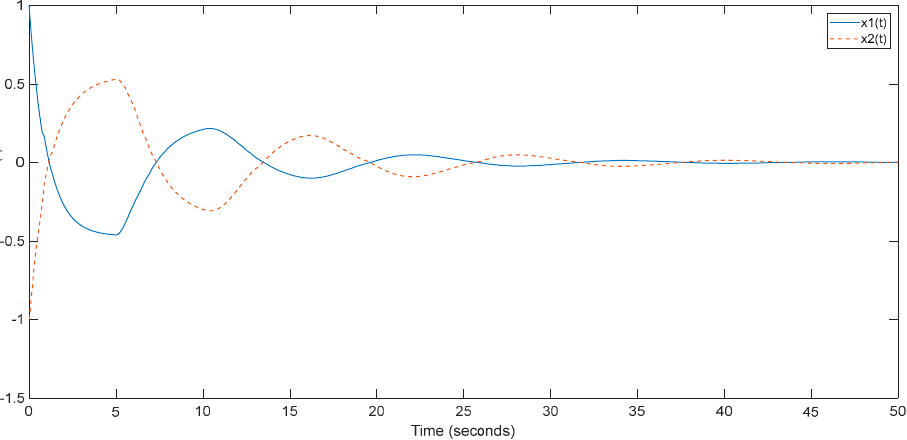
Figure 5. State for synchronous signal in (19) and input in (20) with zero disturbance input.